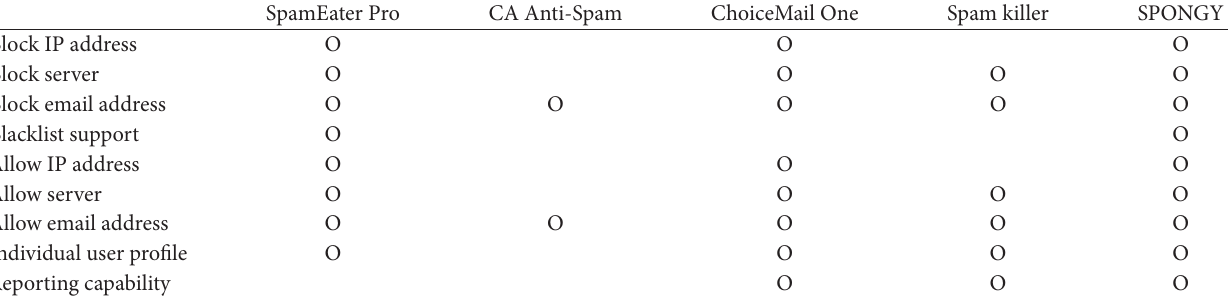
Table 10: Spam filter